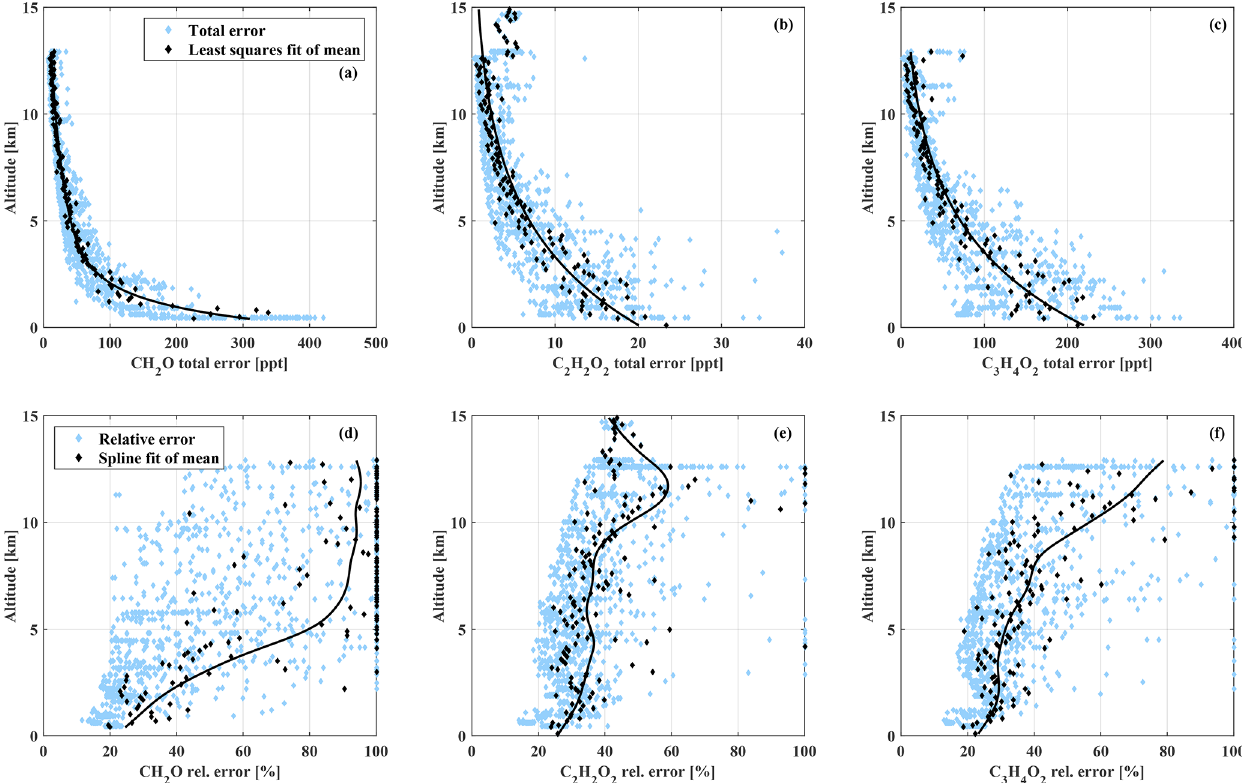
Figure 4. Relative and absolute total precision error of all measurements as a function of the measurement